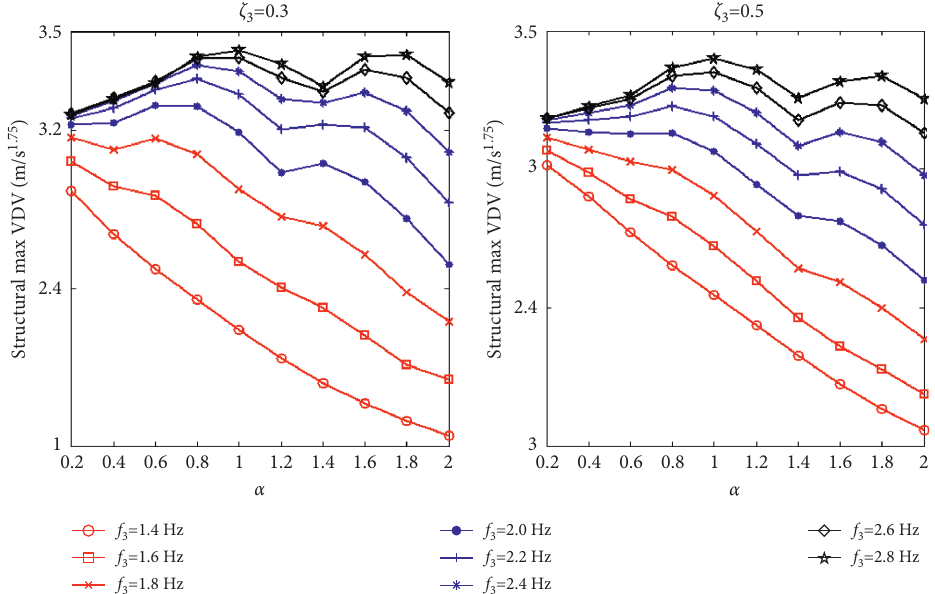
Figure 20: The influence of different α on max acceleration VDV when f